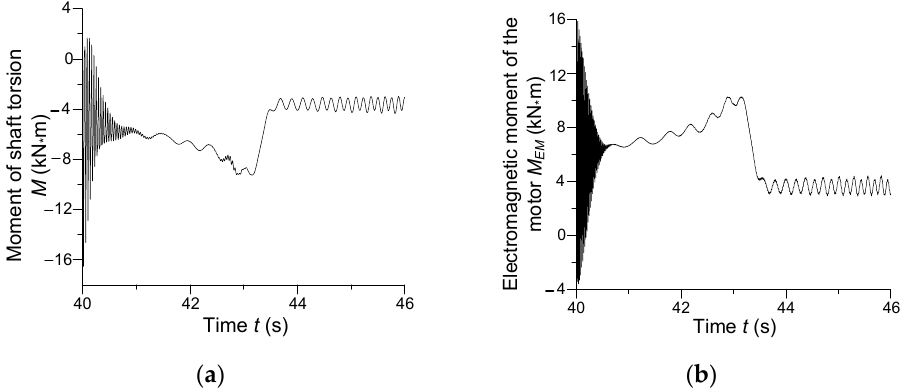
Figure 14. Instantaneous waveforms of the moment and torque in the interval t ∈ (40; 46) s: ( a ) torsion in the middle section of the motion transmission long shaft in the first drive; and ( b ) electromagnetic moment of the first asynchronous motor.